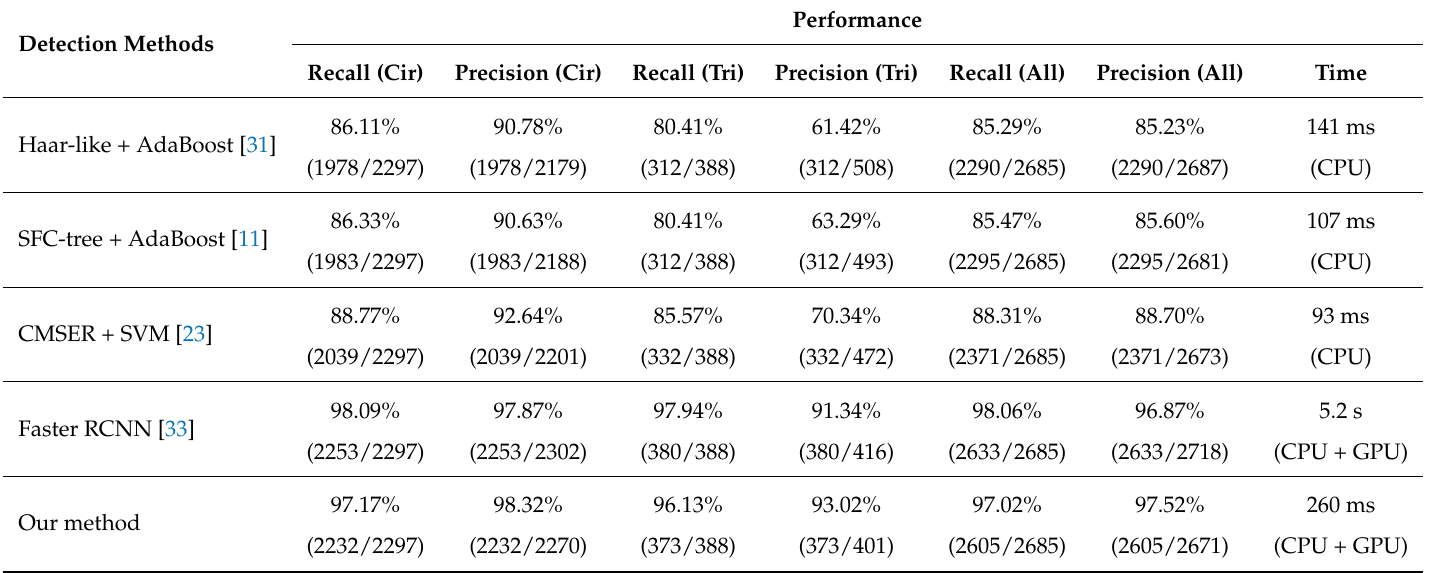
Table 4. Performance of different detection